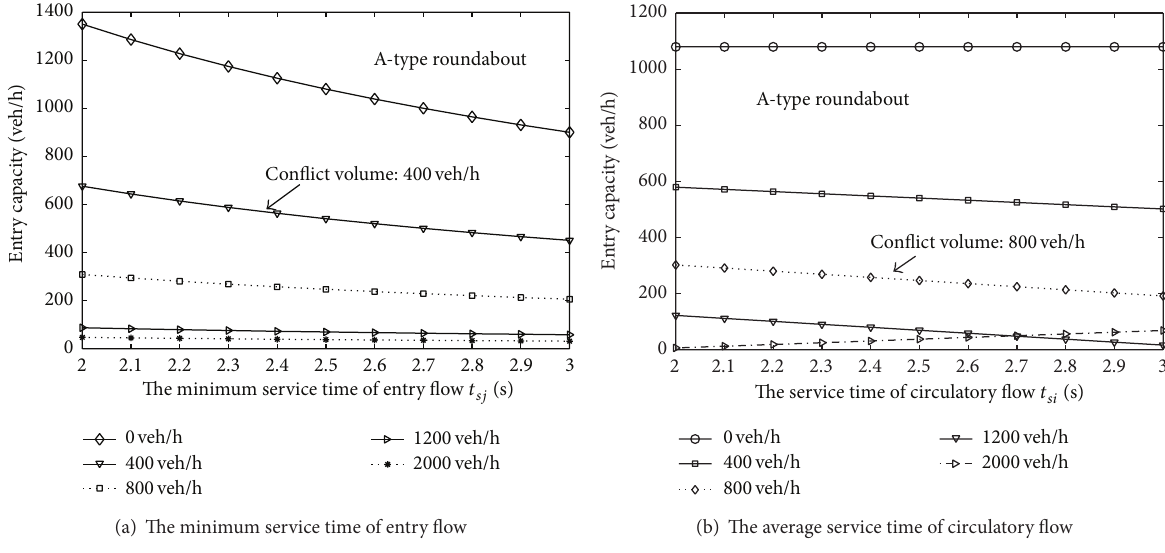
Figure 2: Sensitivity analysis of A-type